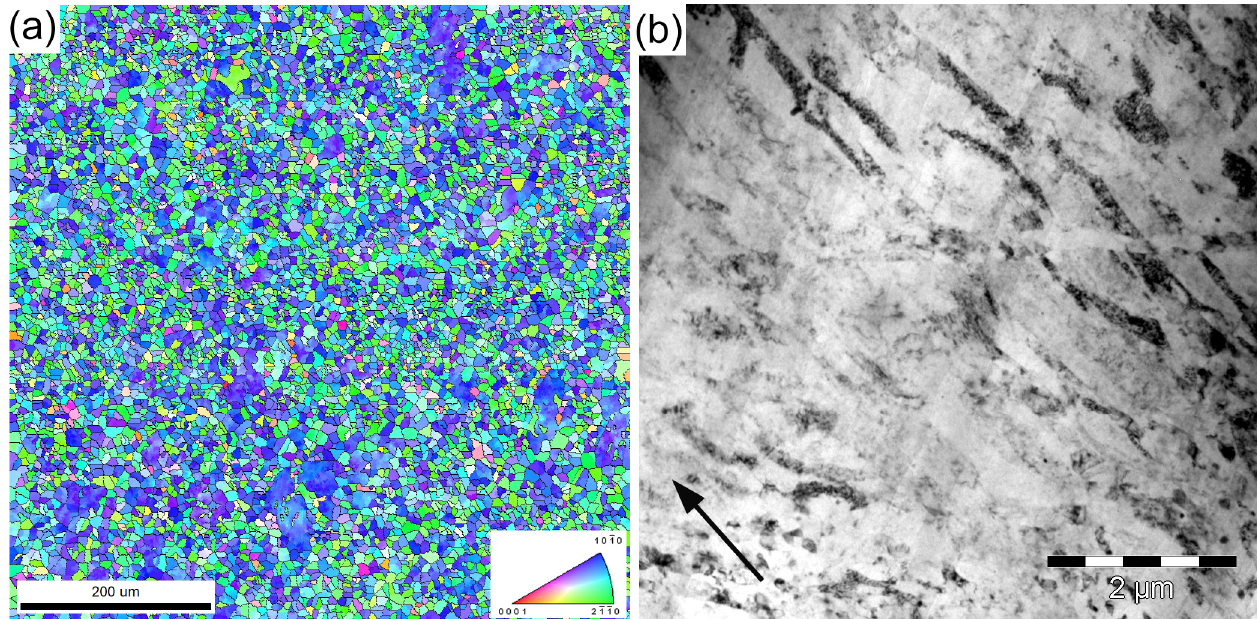
Figure 2. Electron backscattering diffraction (EBSD) orientation map showing the grain structure of the alloy Mg-4Zn-0.16Ca in the cross-section that is normal regarding the extrusion direction after ECAP followed by rotary swaging ( a ) (the inverse pole color code is shown in the inset as a standard stereographic triangle), and the TEM image representing the typical fine grain structure in the longitudinal direction of the same specimen ( b ) (the arrow indicates the extrusion direction); adapted from